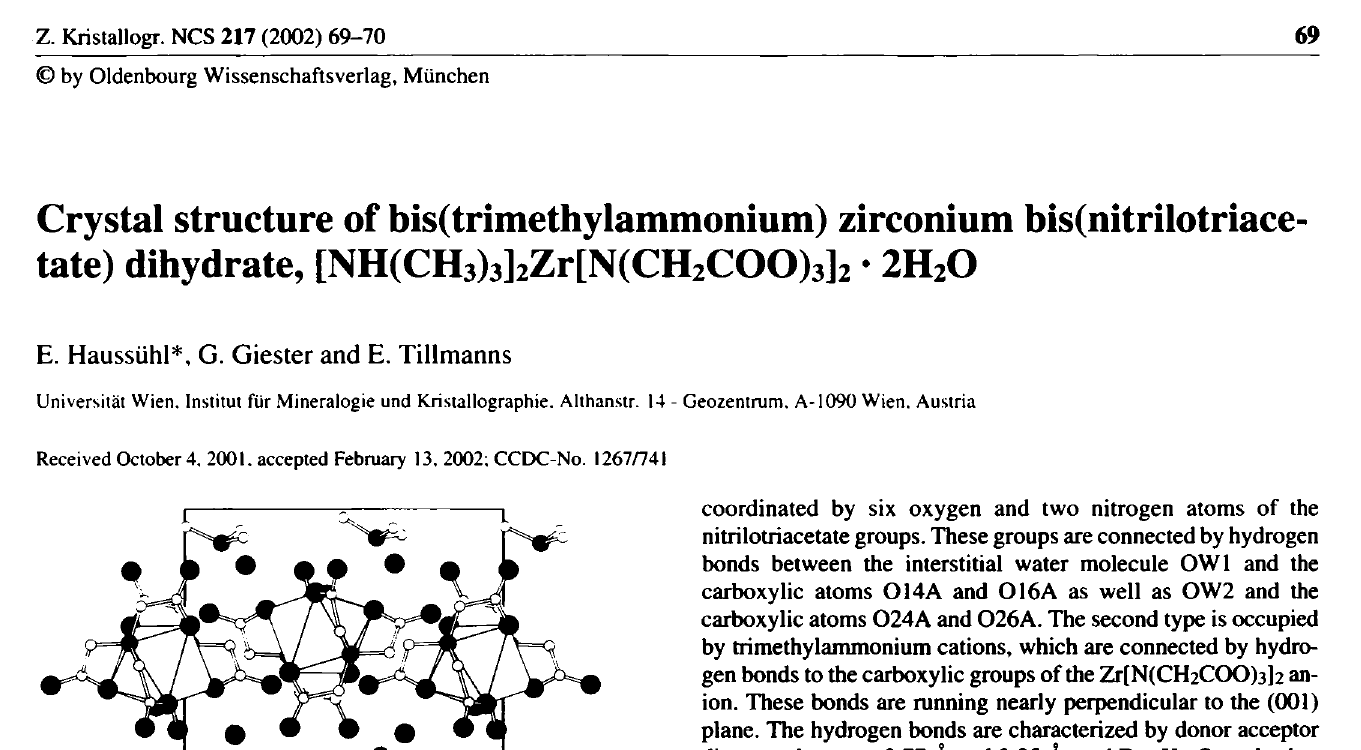
Table 1. Data collection and handling.